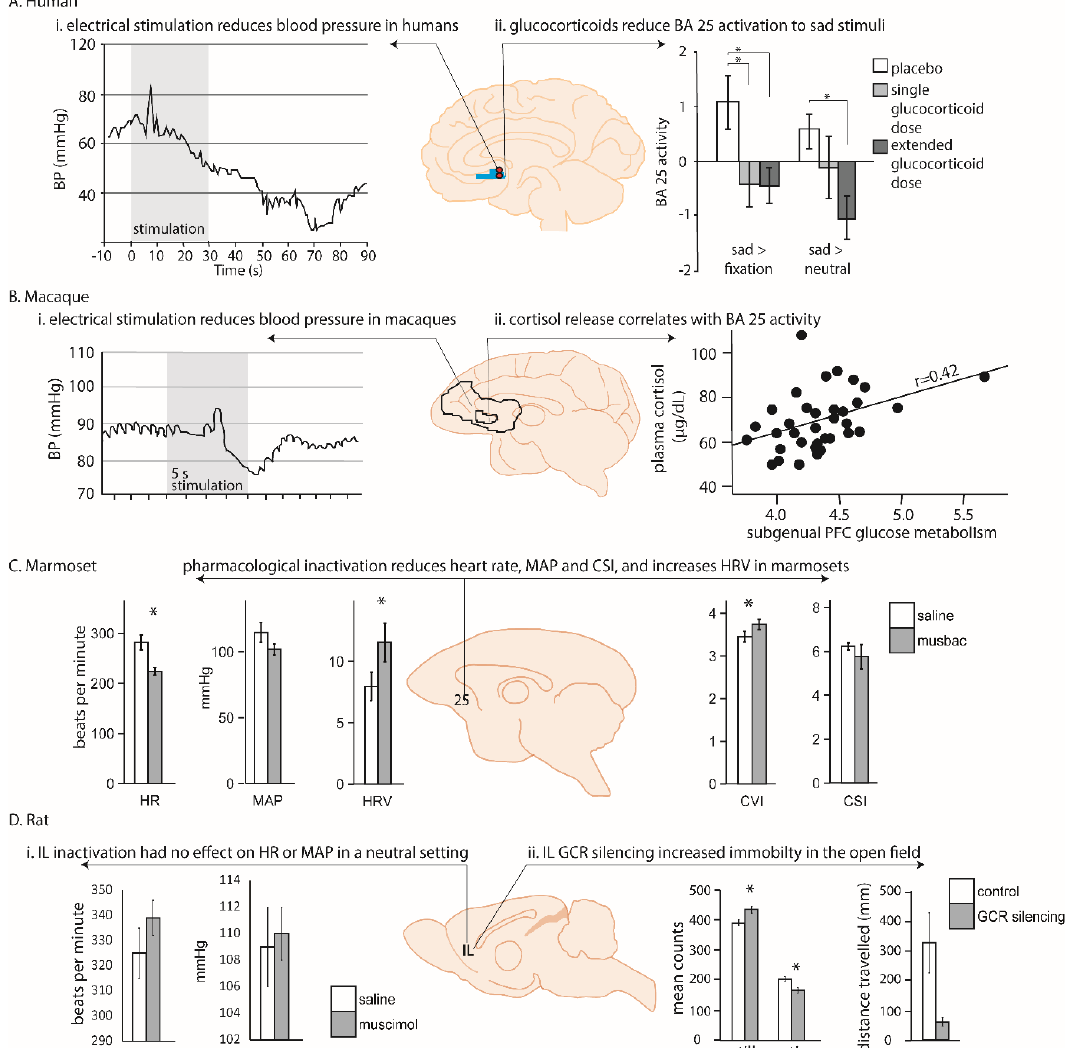
Figure 2. Examples of the relationship between cardiovascular and endocrine responsivity and area 25/infralimbic (IL) activity in emotional and non-emotional conditions in human, macaque, marmoset and rat. ( A ) In humans, ( i ) stimulation of area 25 via deep brain stimulation (red circles indicate stimulation loci) causes a brief hypertension followed by pronounced hypotension in anesthetized humans [34] while ( ii ) the administration of peripheral cortisol decreases area 25 activation to sad stimuli (brain region shaded blue) in the absence of any stressors [36]. ( B ) In macaques ( i ) stimulation of area 25 in anesthetized animals caused a brief hypertension followed by pronounced hypotension [22], similar to humans, and ( ii ) cortisol release correlates with ventromedial prefrontal cortex (vmPFC) activity during neutral conditions (large demarcated area), and specifically with area 25 during both stressful and neutral conditions (small demarcated area; [37]). ( C ) In marmosets, pharmacological inactivation of area 25 with GABA A and B agonists (muscimol and baclofen; ‘musbac’) in a neutral condition caused a reduction in heart rate (HR) and mean arterial blood pressure (MAP) that was accompanied by an increase in heart rate variability (HRV). Subdivision of the cardiac vagal and cardiac sympathetic indices (CVI and CSI) revealed that this HRV change was caused by a selective increase in the parasympathetic CVI [38]. ( D ) In rats ( i ) inactivation of IL had no effect on HR and MAP [39], unlike humans and non-human primates, but ( ii ) selective glucocorticoid receptor (GCR) silencing within the IL reduced activity within the open field test indicating that cortisol can modulate IL’s impact on emotional behavior [40]. Thus, whereas manipulation of area 25 in a neutral setting consistently modulates cardiovascular function in humans and non-human